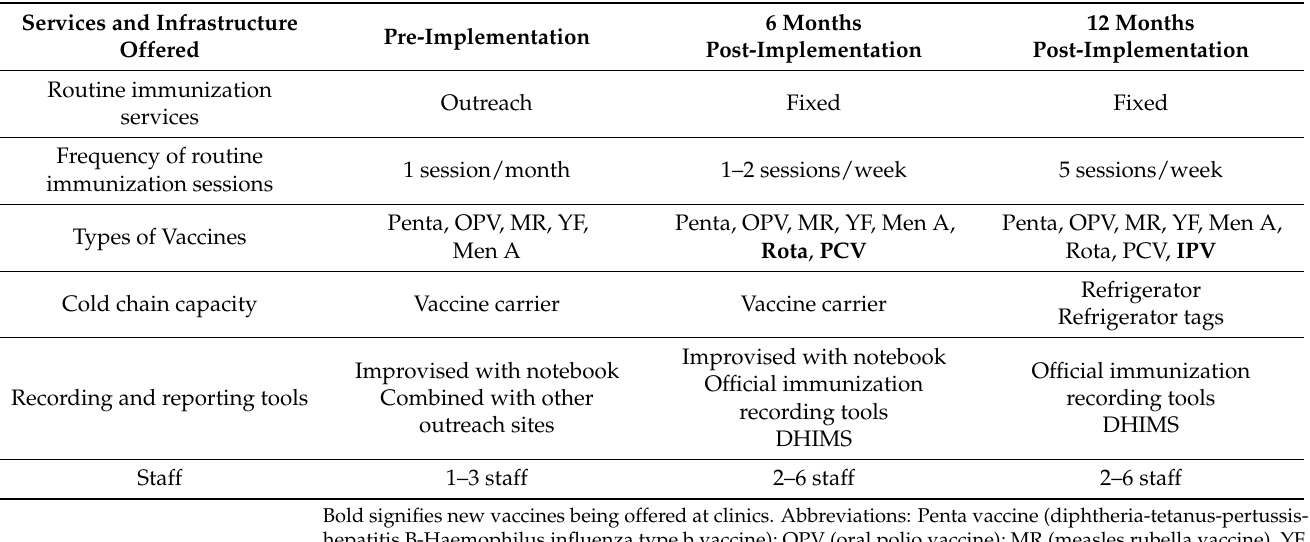
Table 2. Summary of services and clinic infrastructure offered by two container clinics pre- implementation, and six months and twelve months post-implementation in the Accra Sub-Metro, 2017–2018.